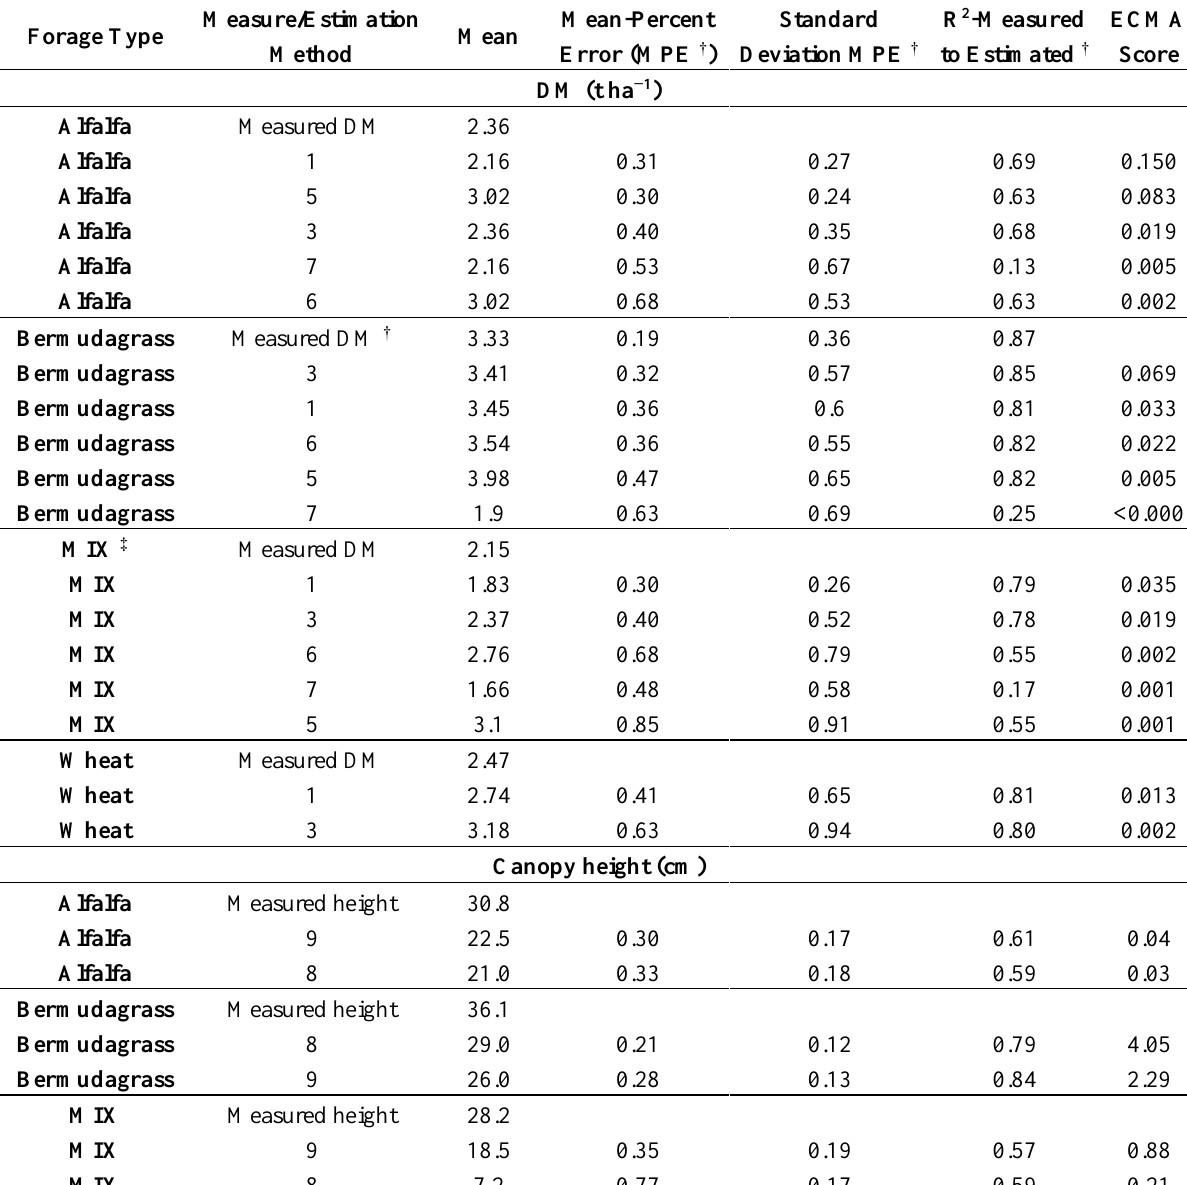
Table 5. Sensor model ranking based on Error, Consistency, and Mean Agreement Score (ECMA) † MPE (0.19), Standard Deviation of MPE (0.36) and R 2 (0.87) for measured were calculated from paired bermudagrass plots. ‡ MIX-Mixture of alfalfa and